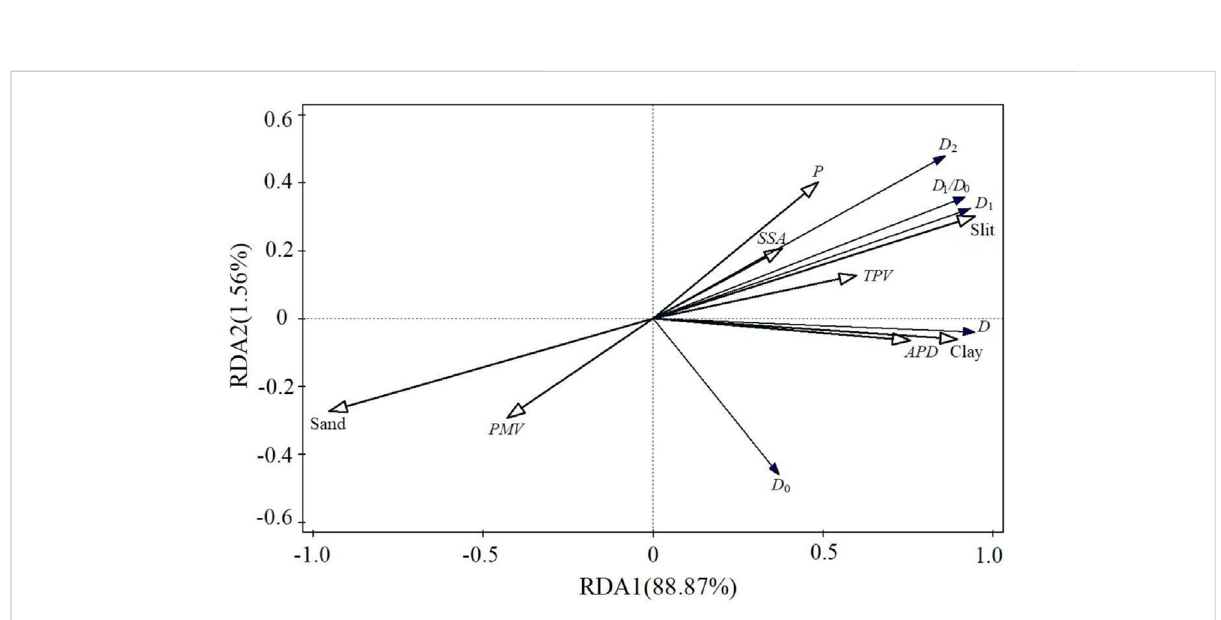
FIGURE 9 Redundancy analysis (RDA) of soil fractal dimensions, PSD, and pore parameters.